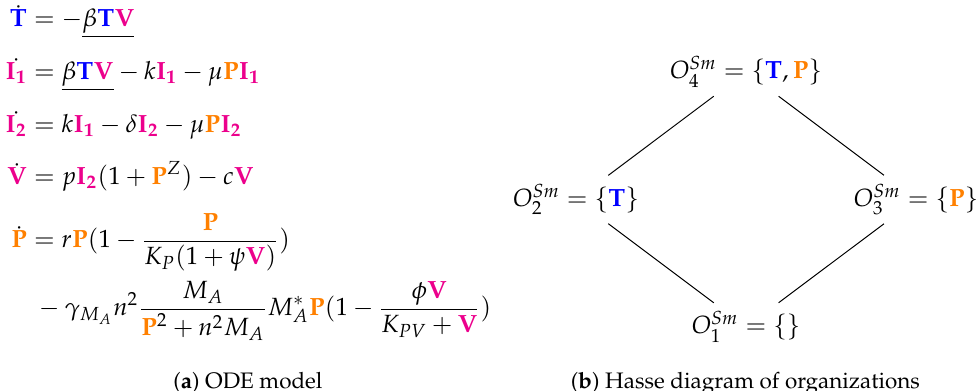
Figure 6. The Smith Model [15] with five variables: susceptible target cells ( T ), two classes of infected cells ( I 1 and I 2 ), free viruses ( V ), and bacteria ( P